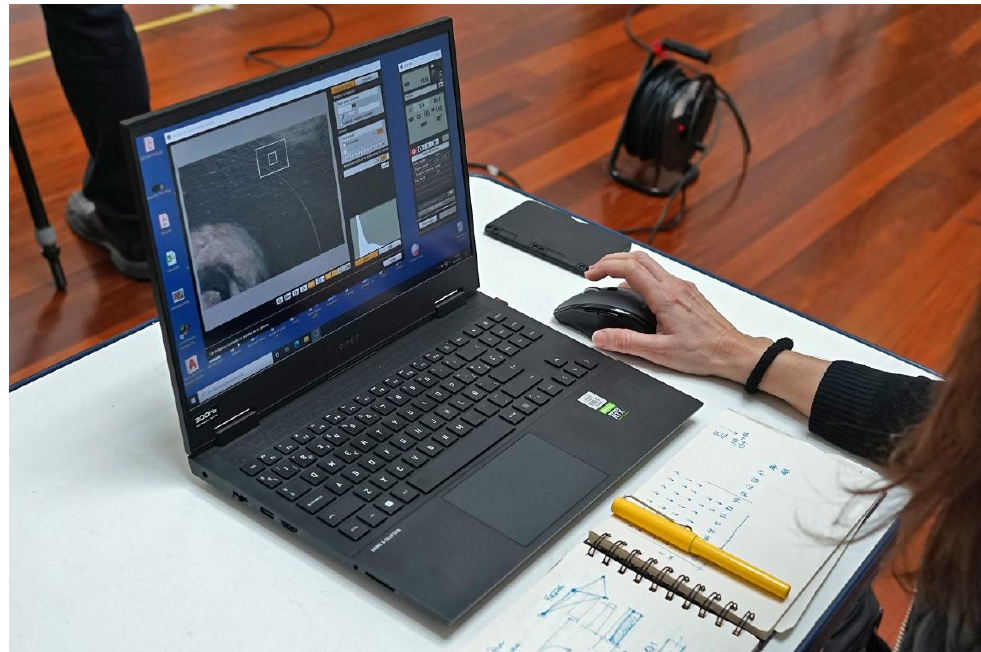
Figure 15. Remote control of the camera with the laptop via Wi-Fi.